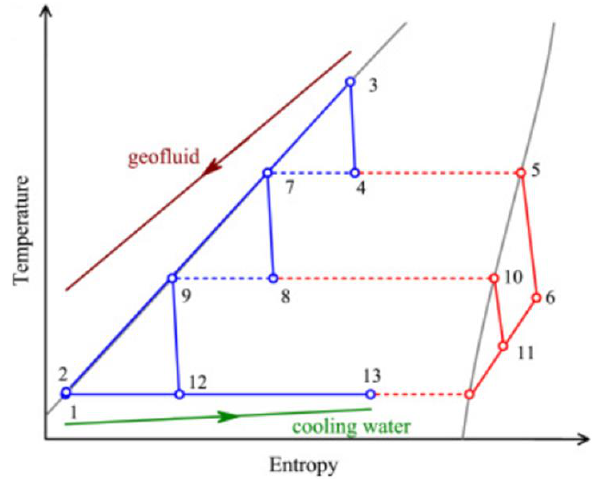
Figure 8. T – s diagram of organic double-flash cycle [ Error! Reference source not found. ].